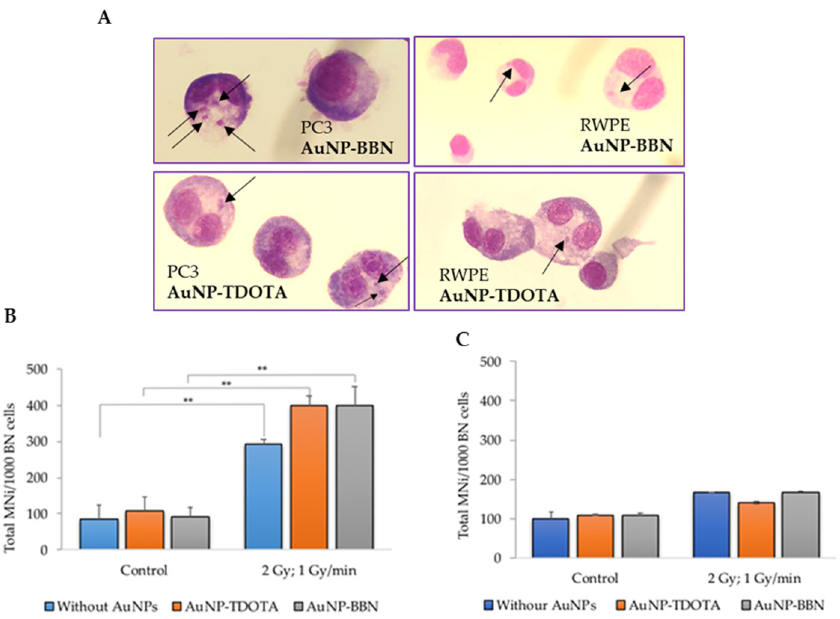
Figure 5. Genotoxic effects, in PC3 and RWPE-1 cells, after incubation with AuNP-TDOTA and AuNP-BBN at a concentration of 36 µg Au/mL followed by 2 Gy of γ -radiation (dose rate of 1 Gy/min), evaluated by the CBMN assay. ( A ) Representative light microscopy images of DNA damage in the tumoral cells PC3 and non-tumoral cells RWPE-1, respectively. The arrows indicate the presence of MNi. Giemsa staining was used to visualize the nuclei and cytoplasm under 40× magnification. ( B , C ) Average number of MNi per 1000 BN cells in PC3 cells and RWPE-1 cells, respectively. Statistical significance was calculated using two-tailed Student’s t -test with irradiation- only cells as the control (** p ≤ 0.001) The results were calculated from independent biological replicates ( n = 2) and are given as the mean ± S.E.M.